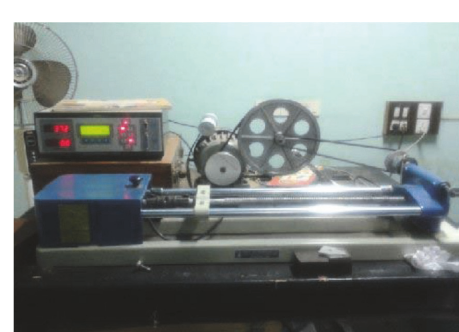
Figure 3: Tensile test-digital tensometer setup.